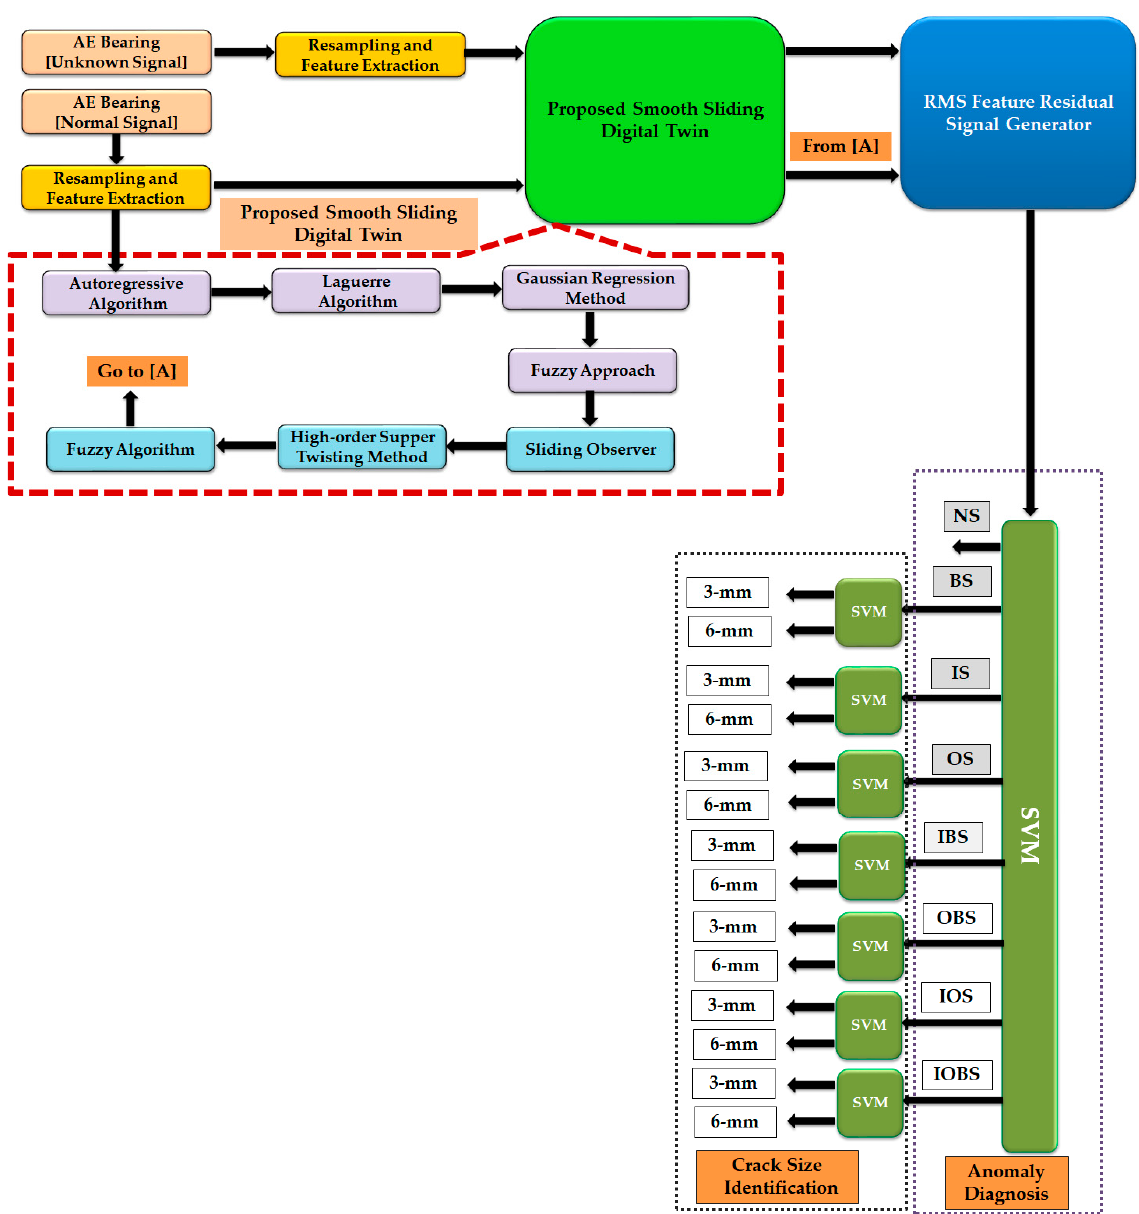
Figure 4. Structure of the proposed robust smooth sliding digital twin with machine learning for anomaly diagnosis and crack size identification.